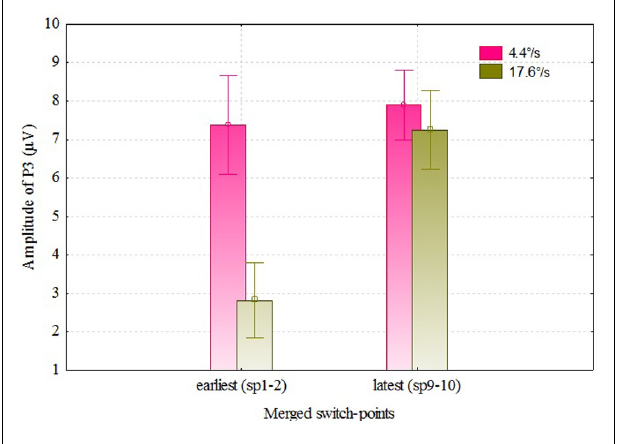
(17.6 ◦ /s) r = − 0.075, p = 0.061, but significant for slower